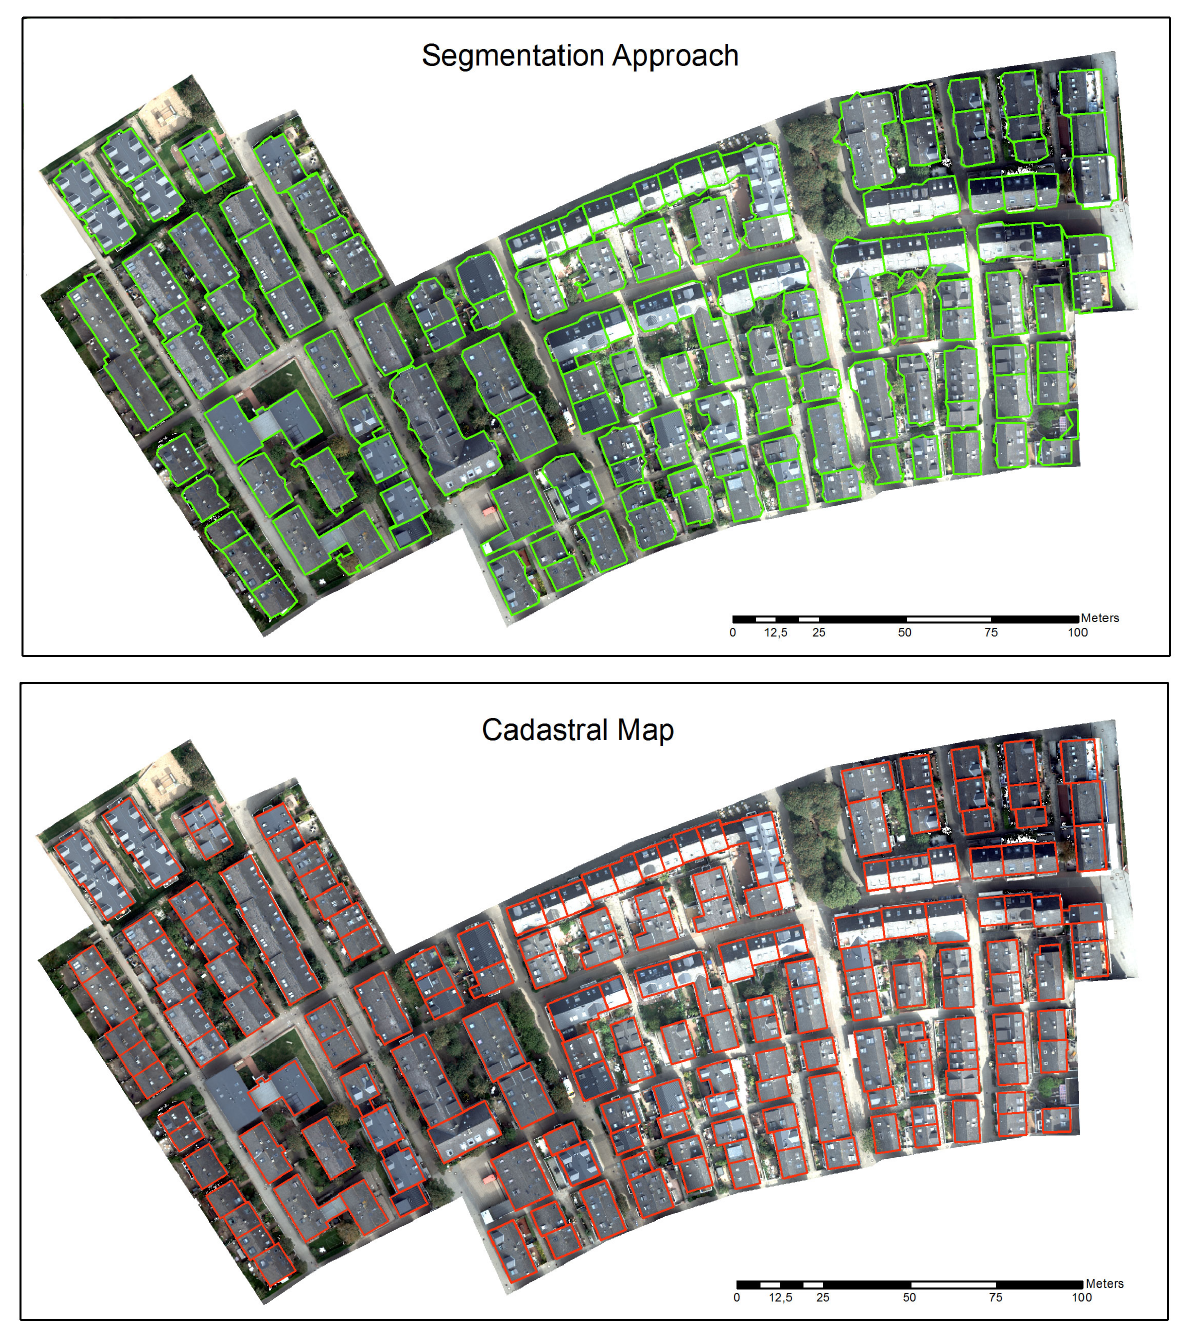
Figure 5. Result after the segmentation approach (top) vs. cadastral map